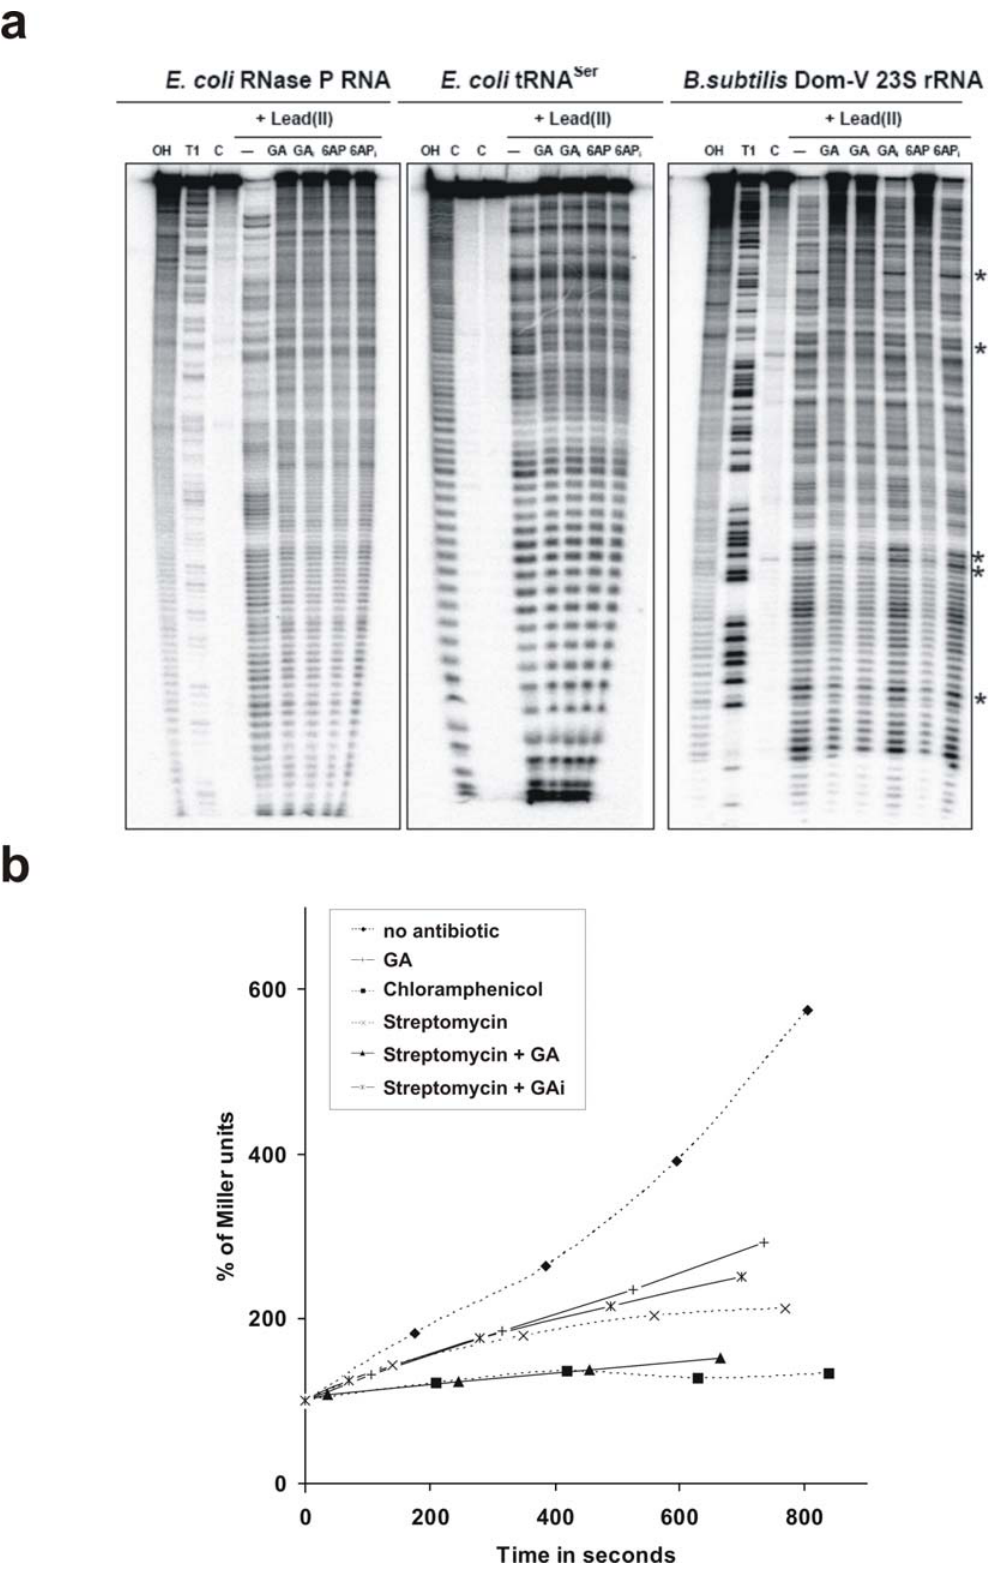
Figure 6. 6AP and GA specifically bind to some common positions on domain V of large rRNA and inhibit the invivo protein folding activity of the ribosome in E.coli . a. Chemical foot printing analysis of binding of 6AP and GA on various RNA. Asterisks indicate positions protected of degradation by Pb 2 + . Note that only 6AP and GA are able to protect some common positions specifically on Domain V of B. subtilis 23S rRNA (right gel) b . The increase in b -Gal activity was determined as a function of time in E. coli cells induced by IPTG and treated by the indicated